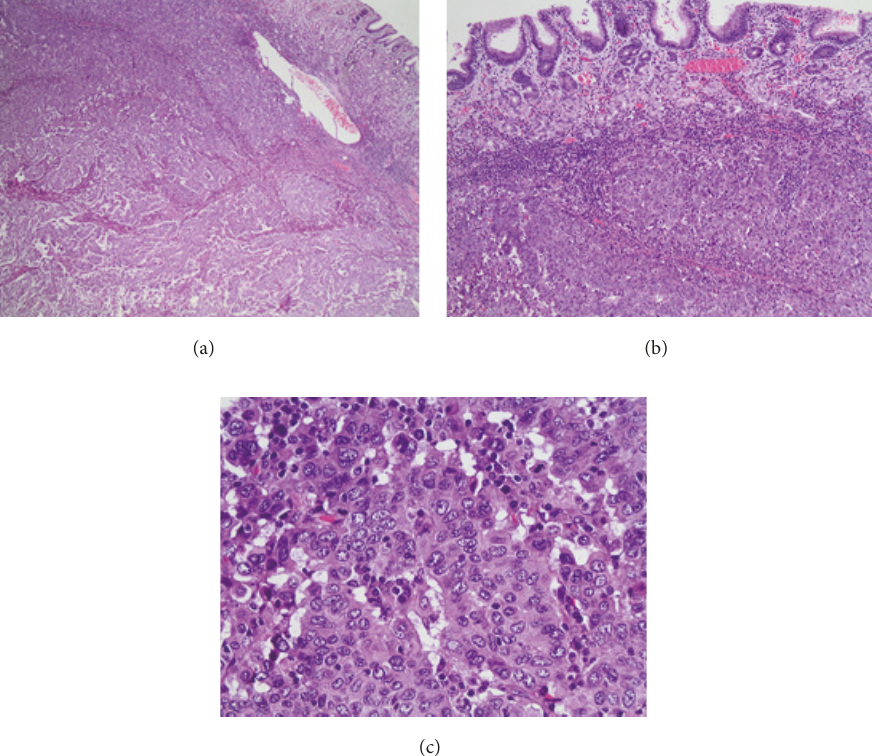
Figure 2: Histologic H&E stained total gastrectomy. (a) Well-demarcated, poorly differentiated carcinoma with an organoid growth pattern and pushing borders ((a) 20x; (b) 100x). (c) High power view of organoid growth pattern and abundant peritumoral lymphocytic response